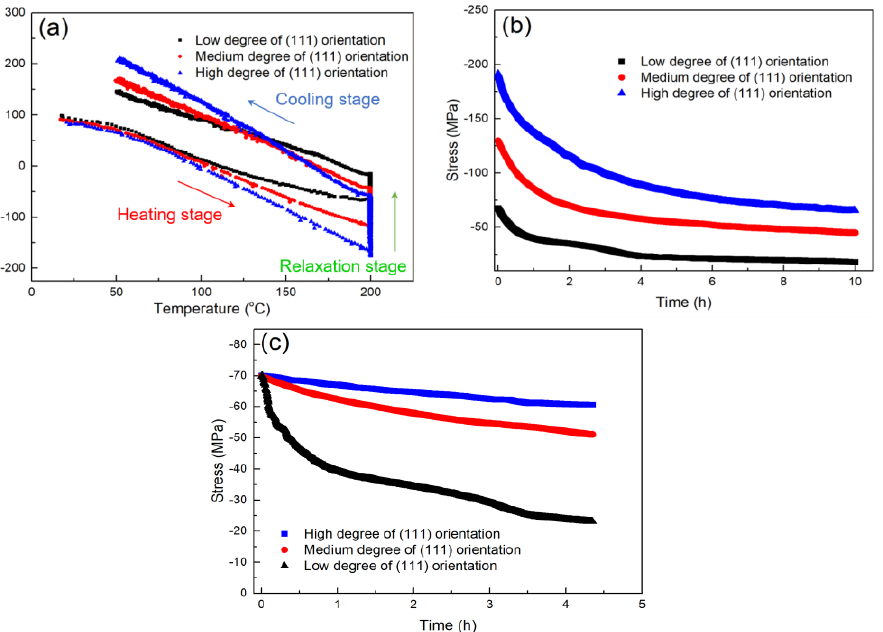
Figure 4. ( a ) Thermal-stress behaviors of the nt-Cu films with different degrees of (111) orientation. Note that the films with high, medium, and low degrees of (111) orientation, respectively, represent the samples shown in Figure 2a–c. ( b ) Stress relaxation of the films with different degrees of (111) orientation. ( c ) Stress relaxation plotted from the same value of initial compressive stress at 200 °C.